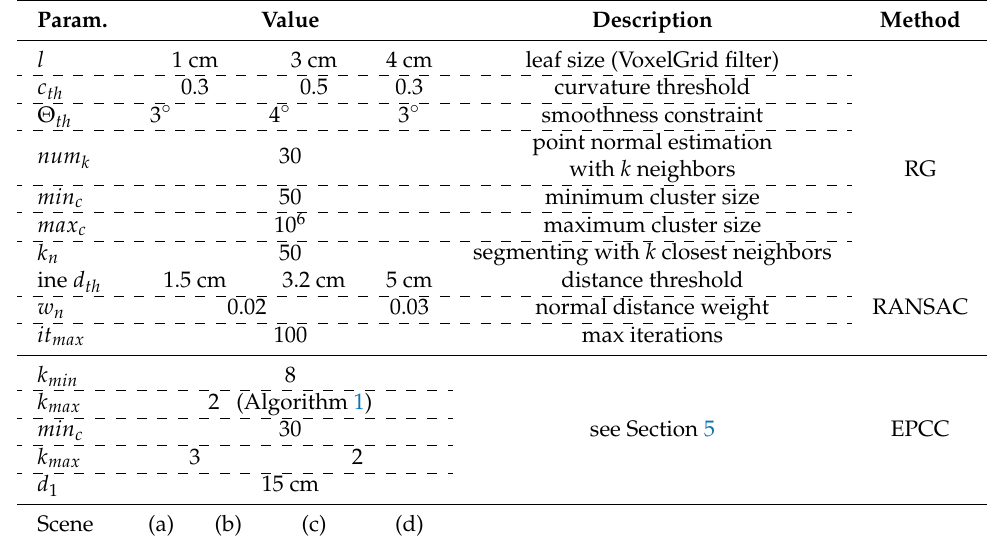
Table 3. Description of input parameters.